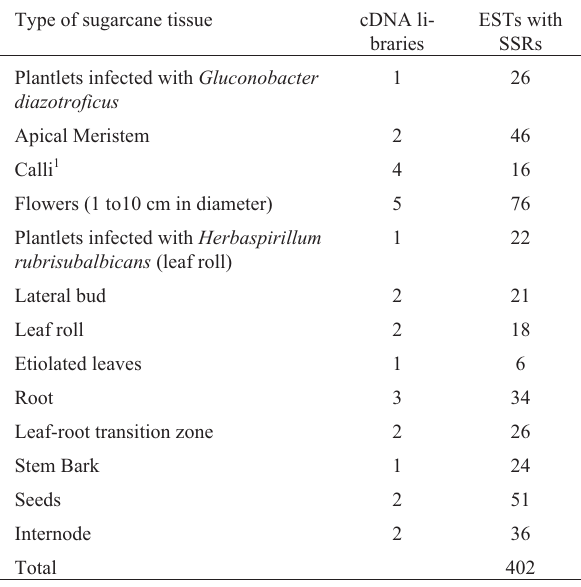
Table III - Number of EST clones carrying SSRs in the cDNA of different sugarcane tissues. Type of sugarcane